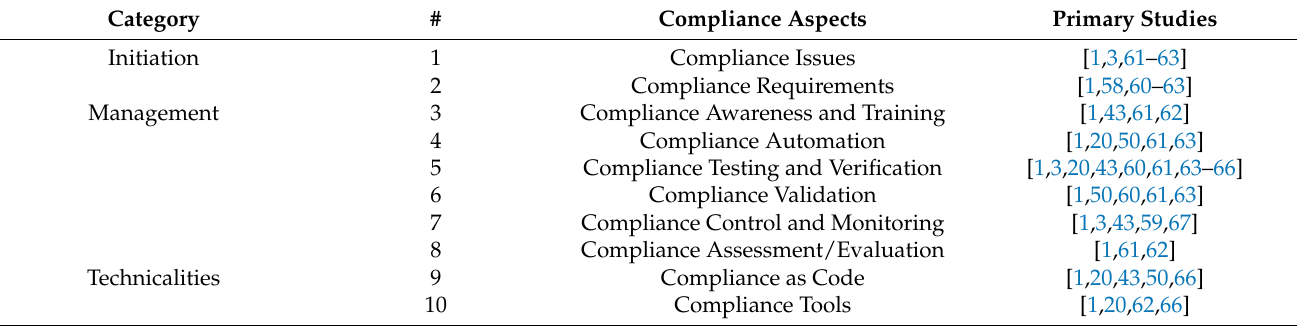
Table 2. Overview of Compliance Aspects in DevSecOps.